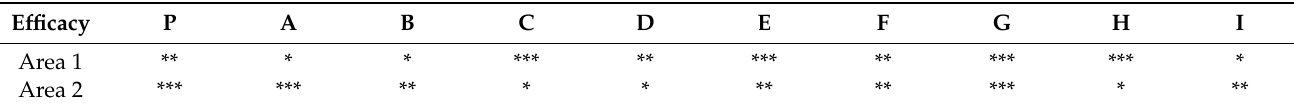
Table 5. The level of efficacy of each product for Area 1 and 2.